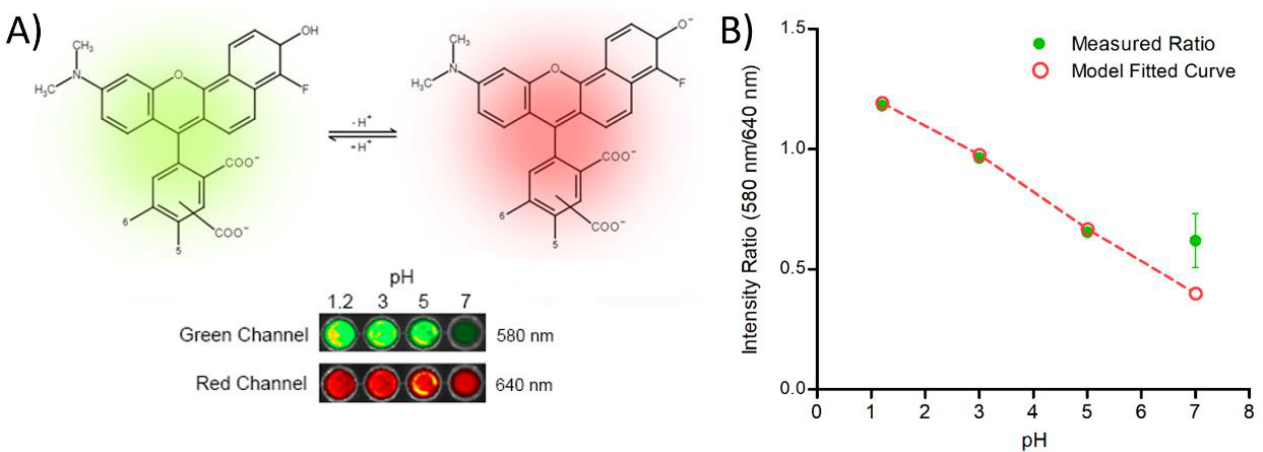
Figure 6. Measurement of pH m using SNARF-4F with TPN at pH 1.2, 3, 5, and 7 for 2 h: ( A ) structural change of SNARF-4F and fluorescence imaging of SNARF-4F-loaded TPN-EC films and ( B ) intensity ratios of SNARF-4F with TPN at 580 nm and 640 nm. The dotted line represents the expected decrease in intensity ratio from pH 1.2 to 7 in absence of pH modulation provided by TPN.